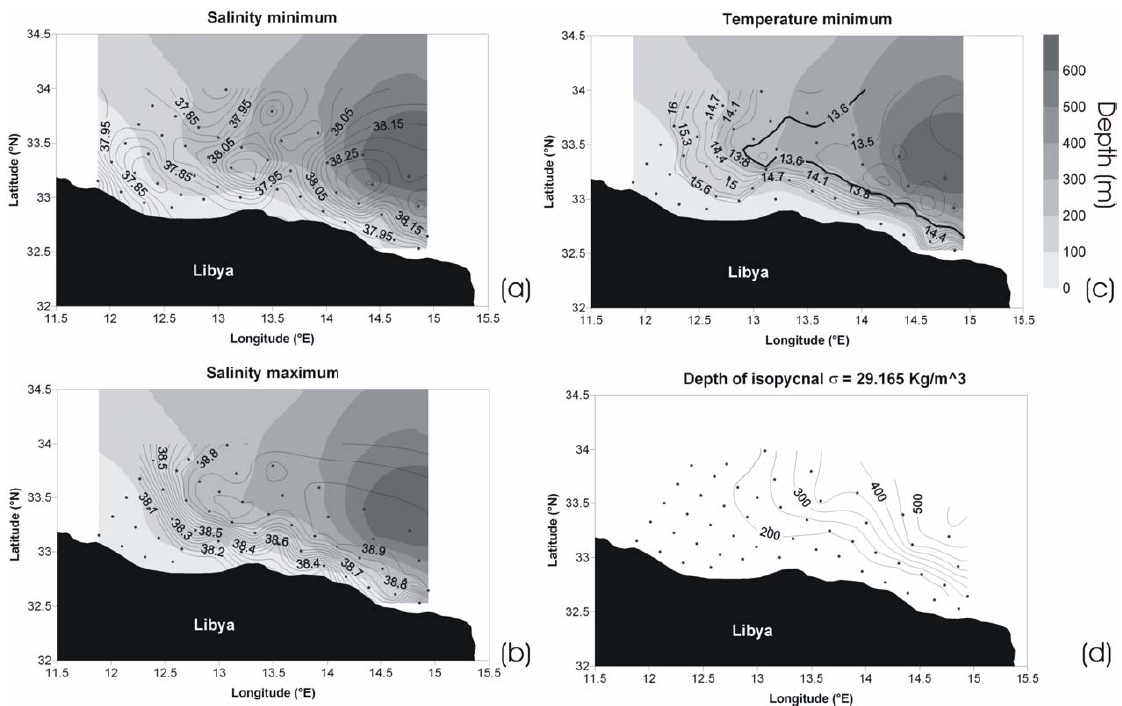
Fig. 2. Horizontal distribution of (a) minimum of Salinity ( S min ) ; (b) maximum of Salinity ( S max ) ; (c) minimum of Potential Temperature ( θ min ) ; (d) depth of σ θ =29.165. Grey contours indicate the bathymetry of the